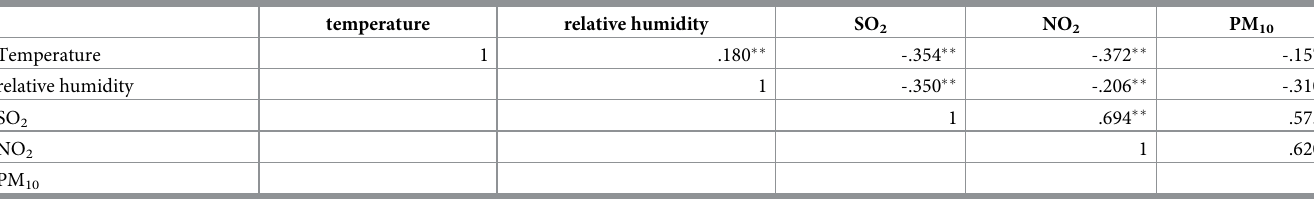
ambient temperature was manifested as a mirror image of J-shape curve within the range of temperature in this study. The risk of AMI was relatively high in low temperature (Risk ratio = 0.988 (95% CI 0.984, 0.993) for under 12˚C) and decreased as temperature increased and speeded up within the temperature zone from 12˚C to 26˚C (Risk ratio = 0.975 (95% CI 0.971, 0.979), but it become increasing again when it is 26˚C although not significantly (Risk ratio = 0.999 (95% CI 0.986, 1.012) (Fig 8A). For GAM model with df set at 4 per year, equal to df = 20 for 5 years, no association could be found (Fig 8B). Table 3. Pearson correlation among ambient temperature, relative humidity and air pollutants � . temperature relative humidity SO 2 NO 2 PM 10 Temperature